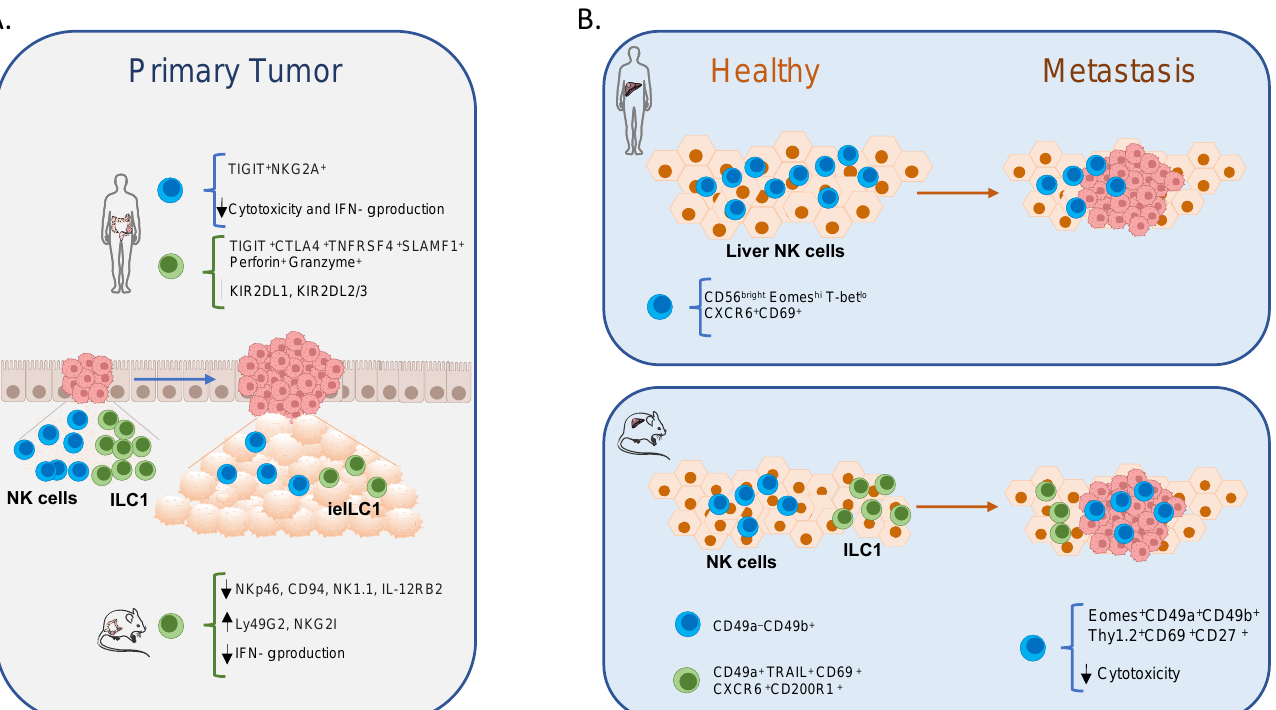
Figure 1. Role of NK cells and ILC1 in CRC progression and metastasis. ( A ) Both NK cells and ILC1 infiltrate CRC at an early stage to block tumor growth. However, tumor-infiltrating NK cells and ILC1 acquire a different phenotype and decrease over time together with their functional abilities. ( B ) CRC liver metastasization occurs along with the reduction of NK cells in humans and significant alterations of phenotypic and functional properties of NK cells in mice. Arrow indicates a decrease or increase.